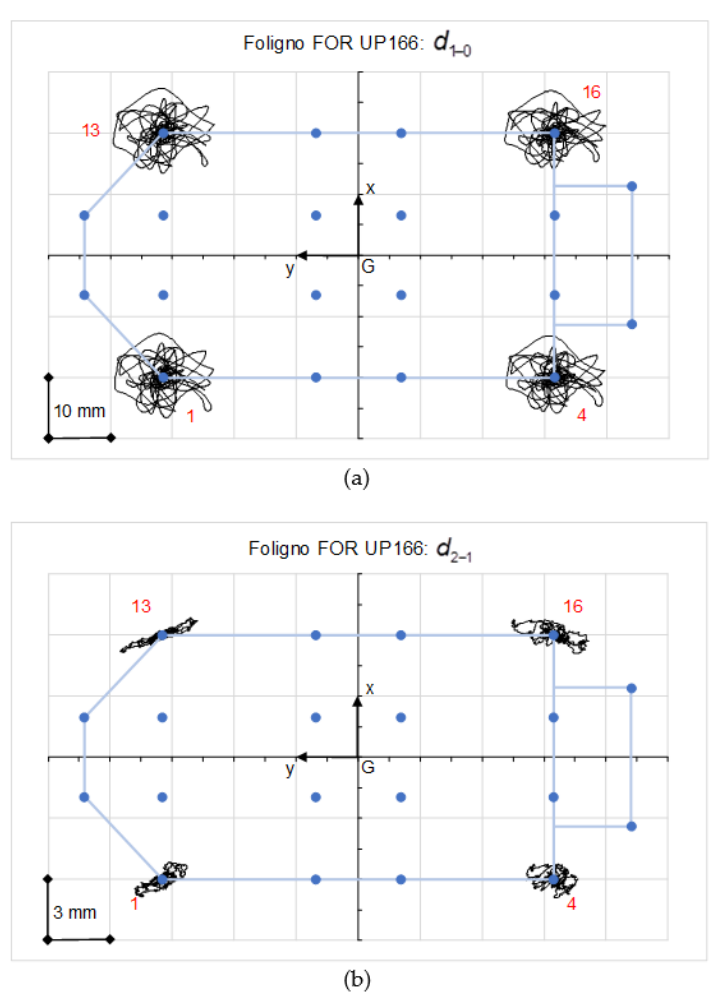
Figure 12. Relative particle motions at the points corresponding to the position of the corner isolation devices between ( a ) L1 and L0, and ( b ) L2 and L1.